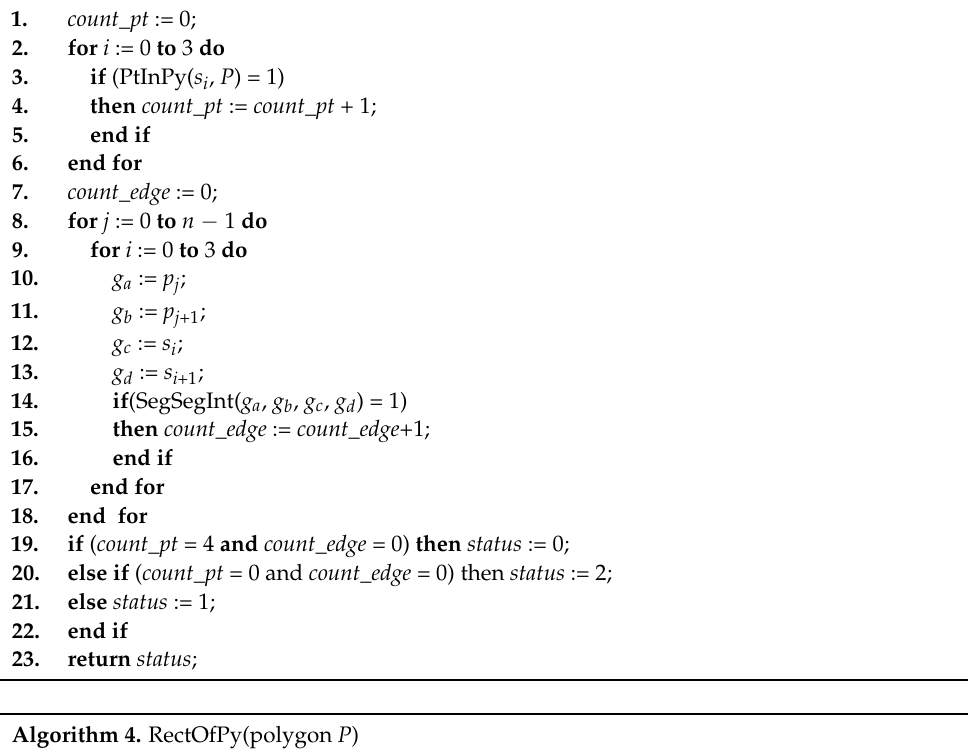
Algorithm 3. SqrInPy(square S , polygon P )